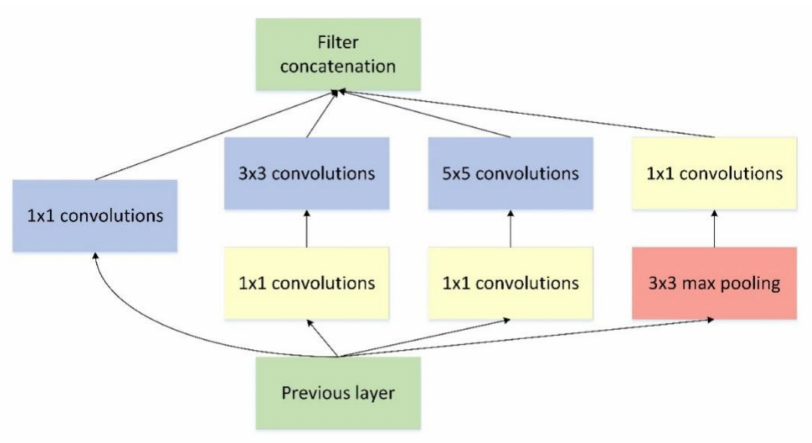
Figure 4. The Inception module proposed by